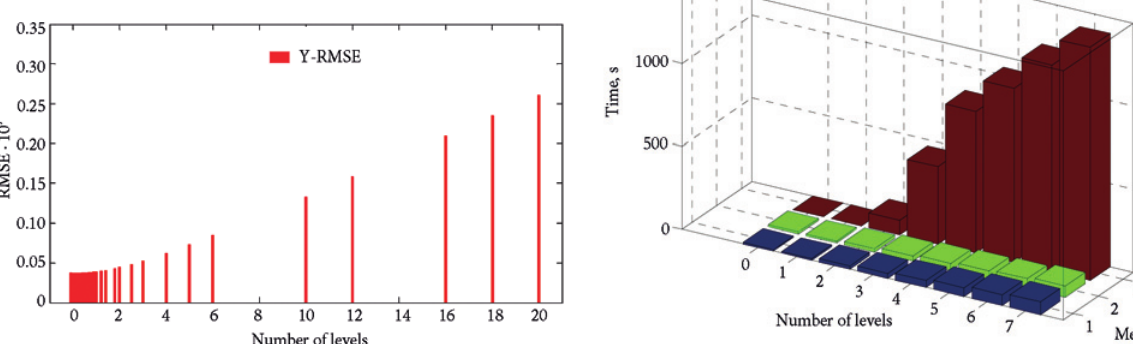
Fig. 13. Influence of iteration termination criterion on speed of